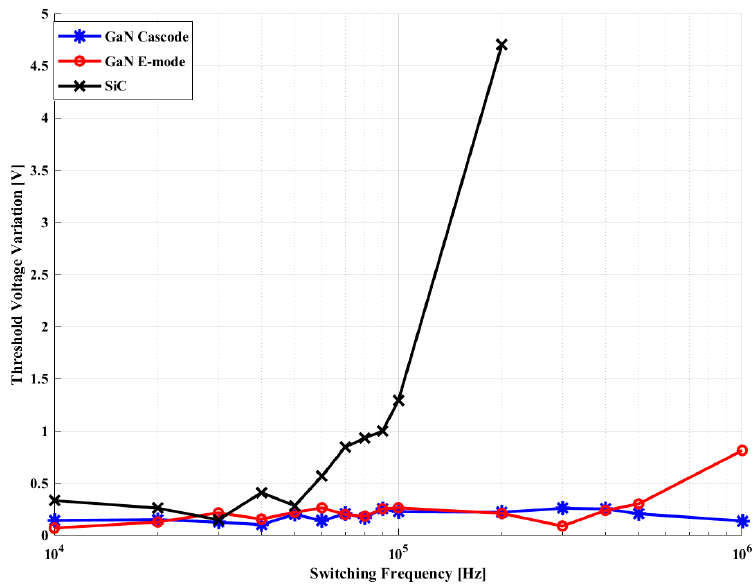
Figure 15. Δ Vth vs. switching frequency. Figure 15. ∆ V th vs. switching frequency.